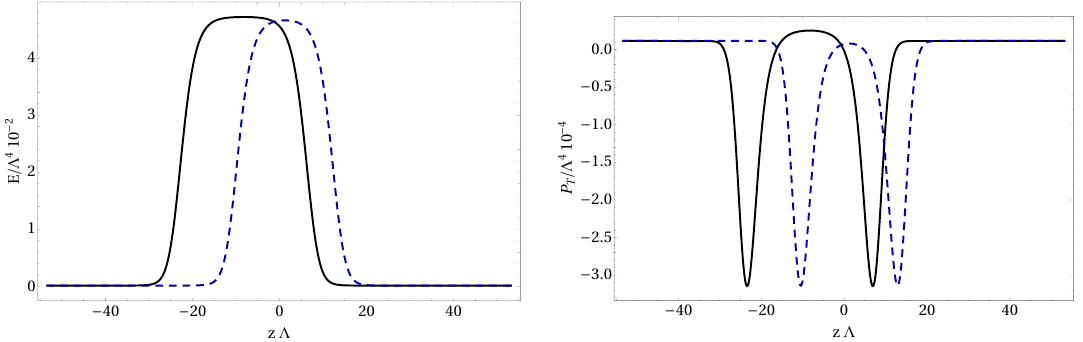
Figure 3 . Longitudinal superposed profiles with φ M = 2 . 35 and L z Λ = 107 for a single plateau in continuous black with initial energy density E 2 and for a single peak in dashed blue with initial energy density E 1 of (left) the local energy density (right) the transverse